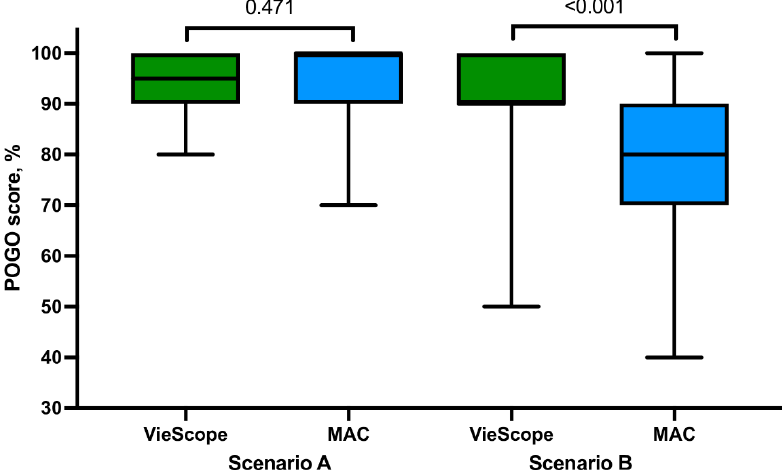
Figure 4. Percentage of glottis opening score among evaluated intubation methods. Legend: MAC = Macintosh laryngoscope; Scenario A = intubation without personal protective equipment for aerosol-generat- ing procedures (PPE-AGP); Scenario B = intubation with PPE-AGP. Table 1. Intubation without personal protective equipment for aerosol-generating procedures (PPE- AGP) scenario.